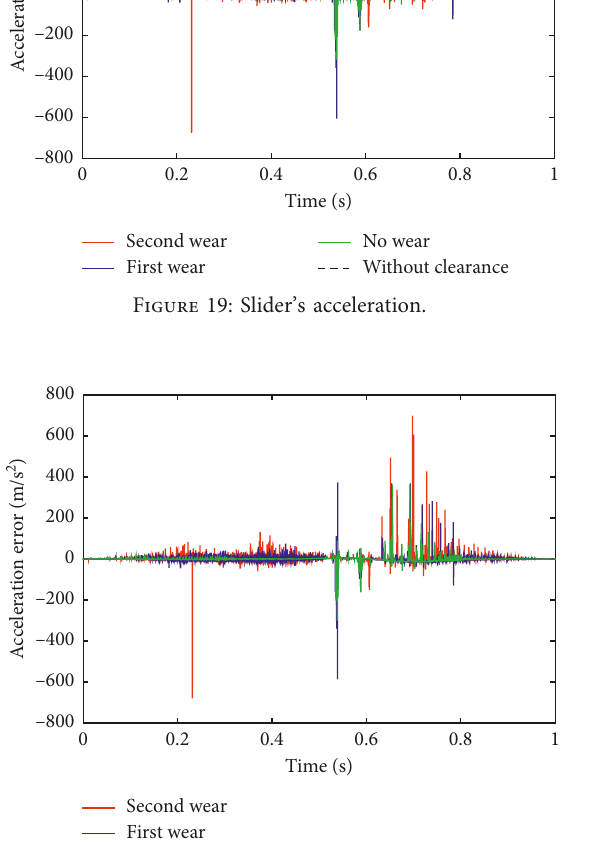
Figure 20: Slider’s acceleration error.